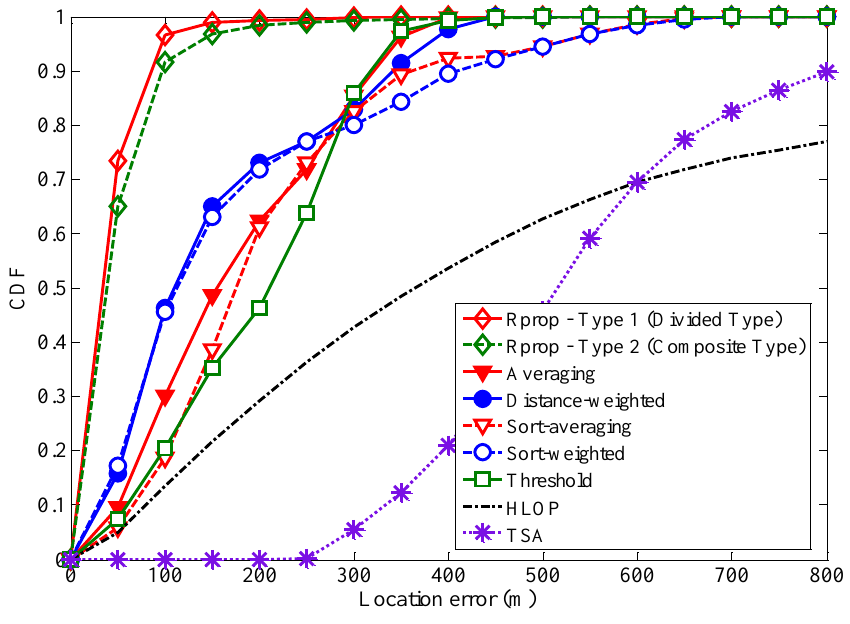
Figure 10. CDFs of the location error with distance-dependent NLOS error.